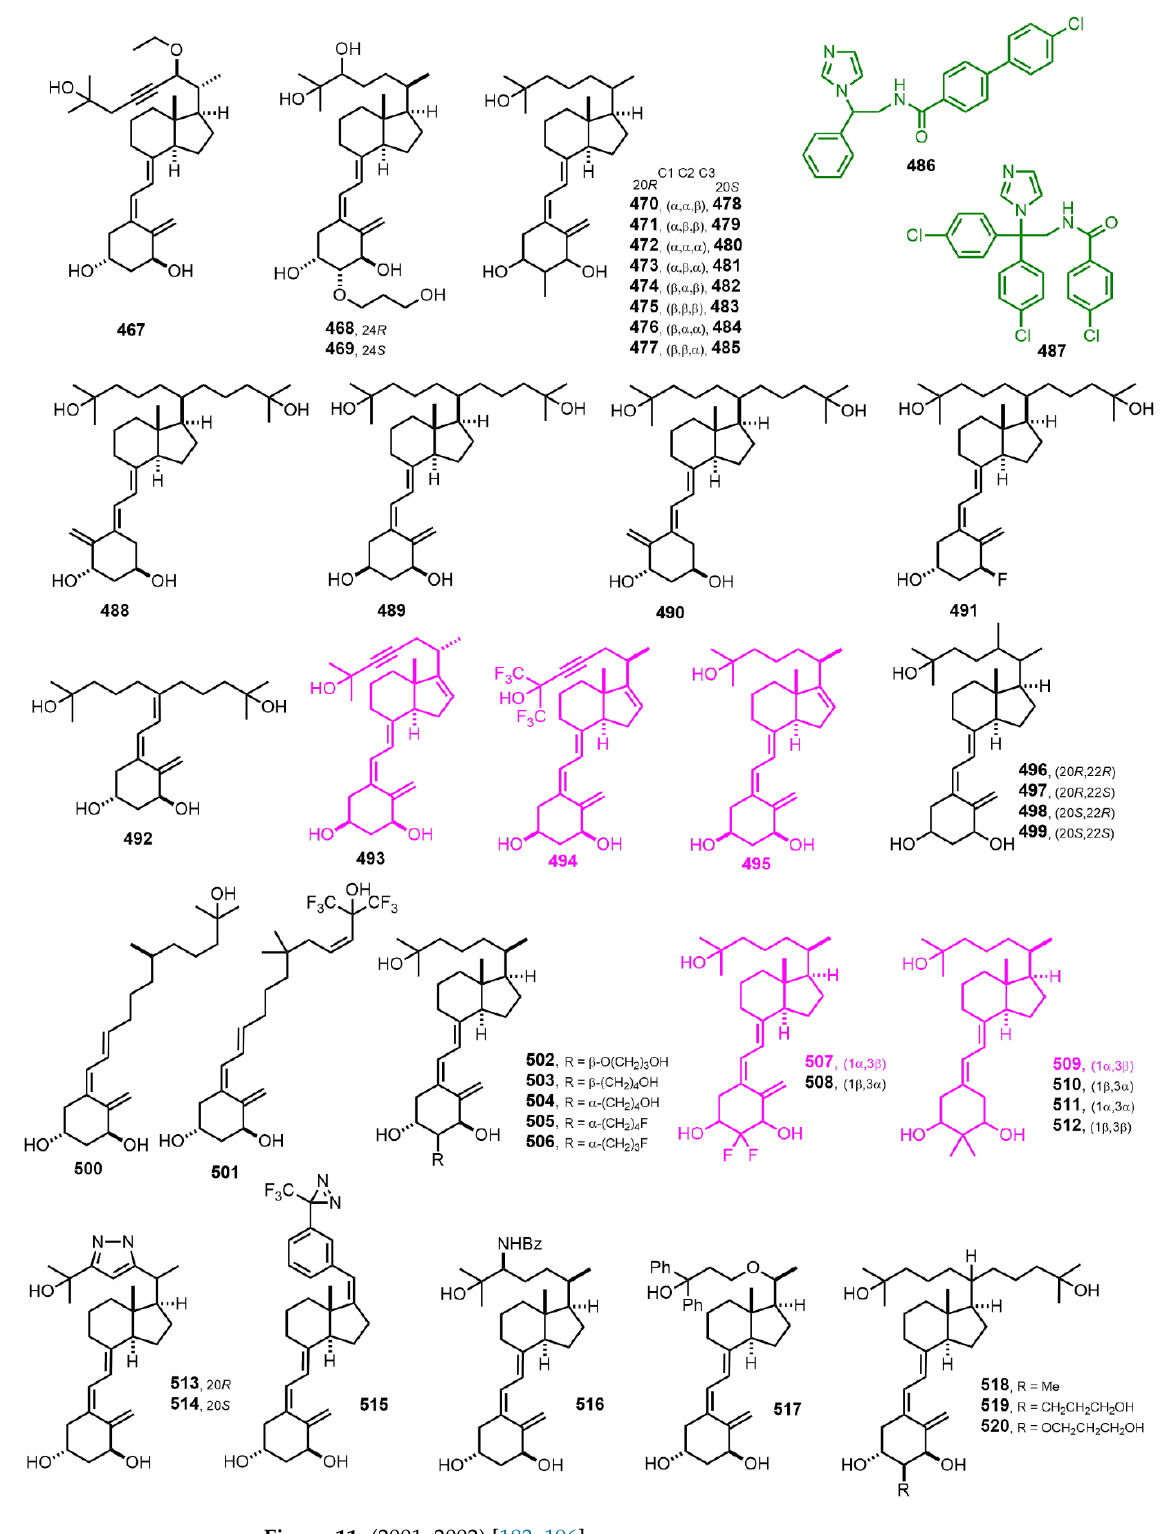
Figure 11. (2001-2002) [183 – 196].